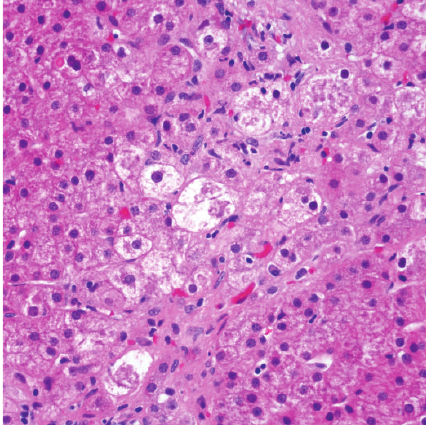
Figure2:MarkedballoonedhepatocyteswithMallory-Denkbodies without